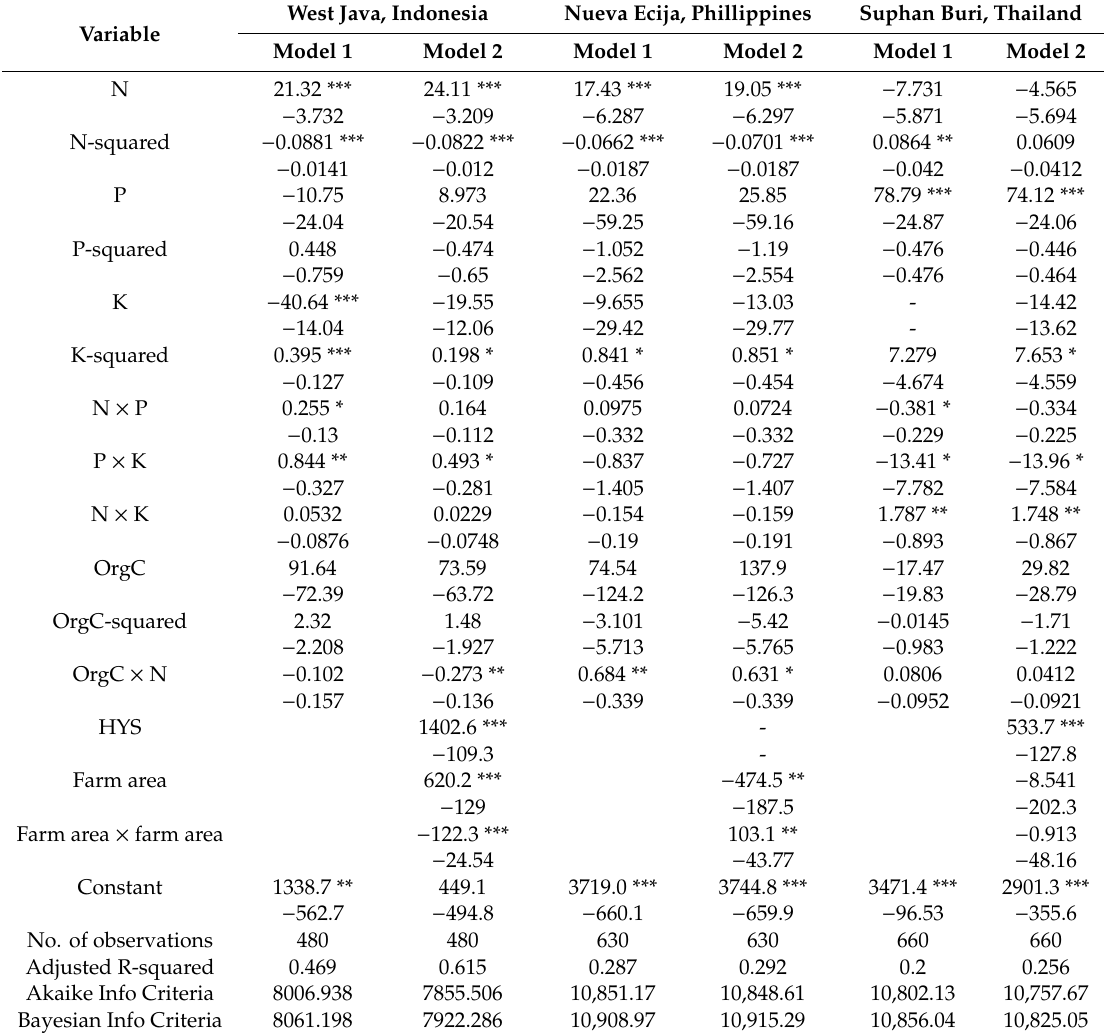
Table 5. Production function estimates using two versions of the quadratic model in Indonesia, Philippines, and